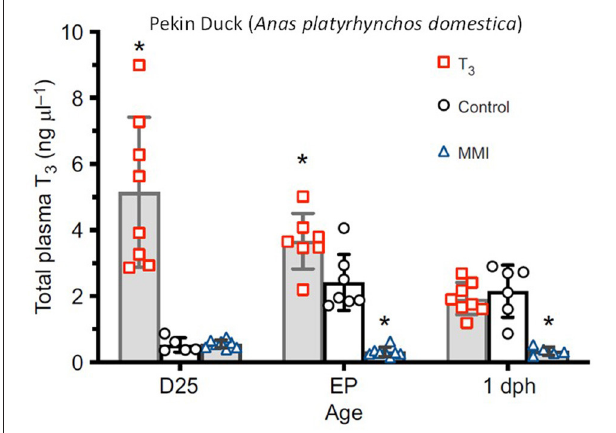
FIGURE 5 | Manipulation of plasma thyroid hormone (T 3 ) levels in the Pekin duck ( Anas platyrhynchos domestica ). T 3 levels were changed by either injection of T3 or by suppression of its synthesis by injection of the thyroid-peroxidase inhibitor MMI. Total plasma [T 3 ] rises from almost undetectable at embryonic day 25 (d25) to ∼ 2 ng . µ l − 1 at external pipping (EP) and 1 day posthatch (1 dph). Injection of T 3 , however, elevates total plasma [T 3 ] at D25 and EP. MMI strongly suppresses [T 3 ] at all examined stages (from Holmes and Ottinger, 2003). *Statistically significant difference.